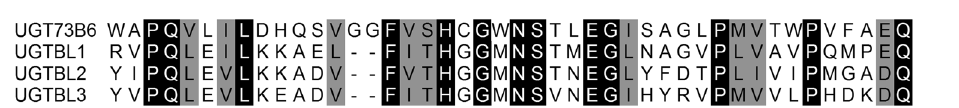
Figure 3. Motif sequence alignment of UGT BL 1, UGT BL 2, UGT BL 3 and